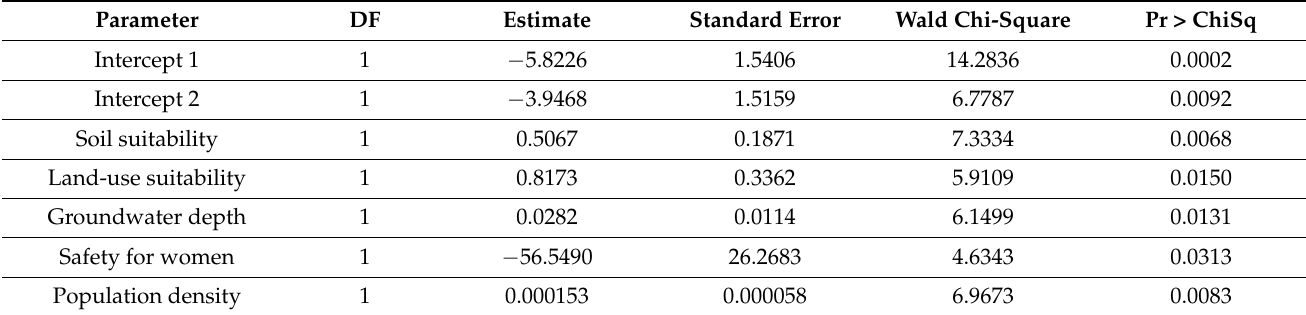
Table 5. Results of stepwise ordered logistic regression on urban gardening suitability.